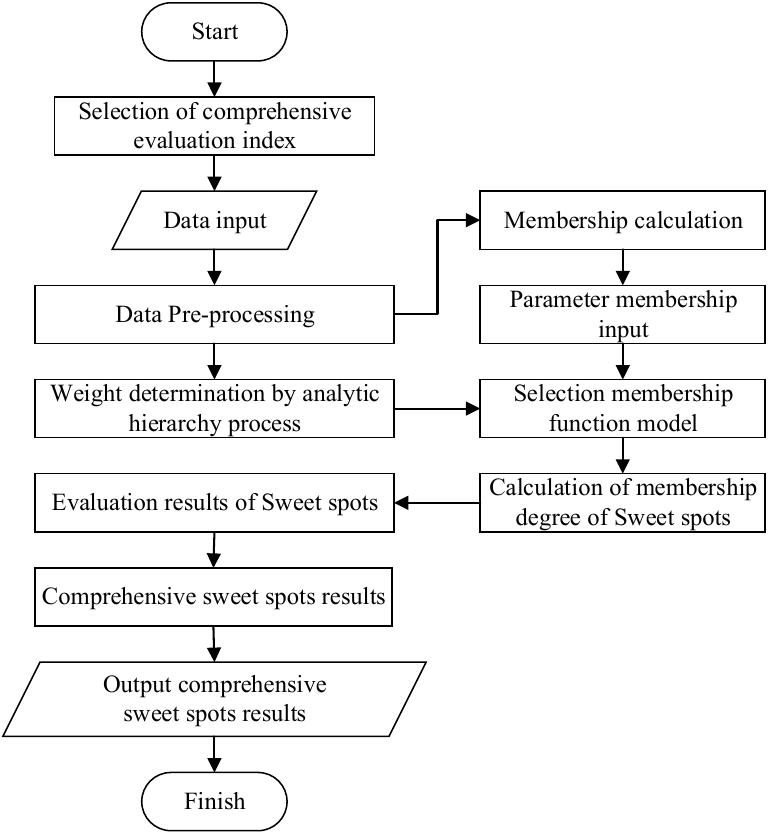
Figure 3. Technical process of comprehensive sweet spots using fuzzy comprehensive evaluation directly based on evaluation parameters.